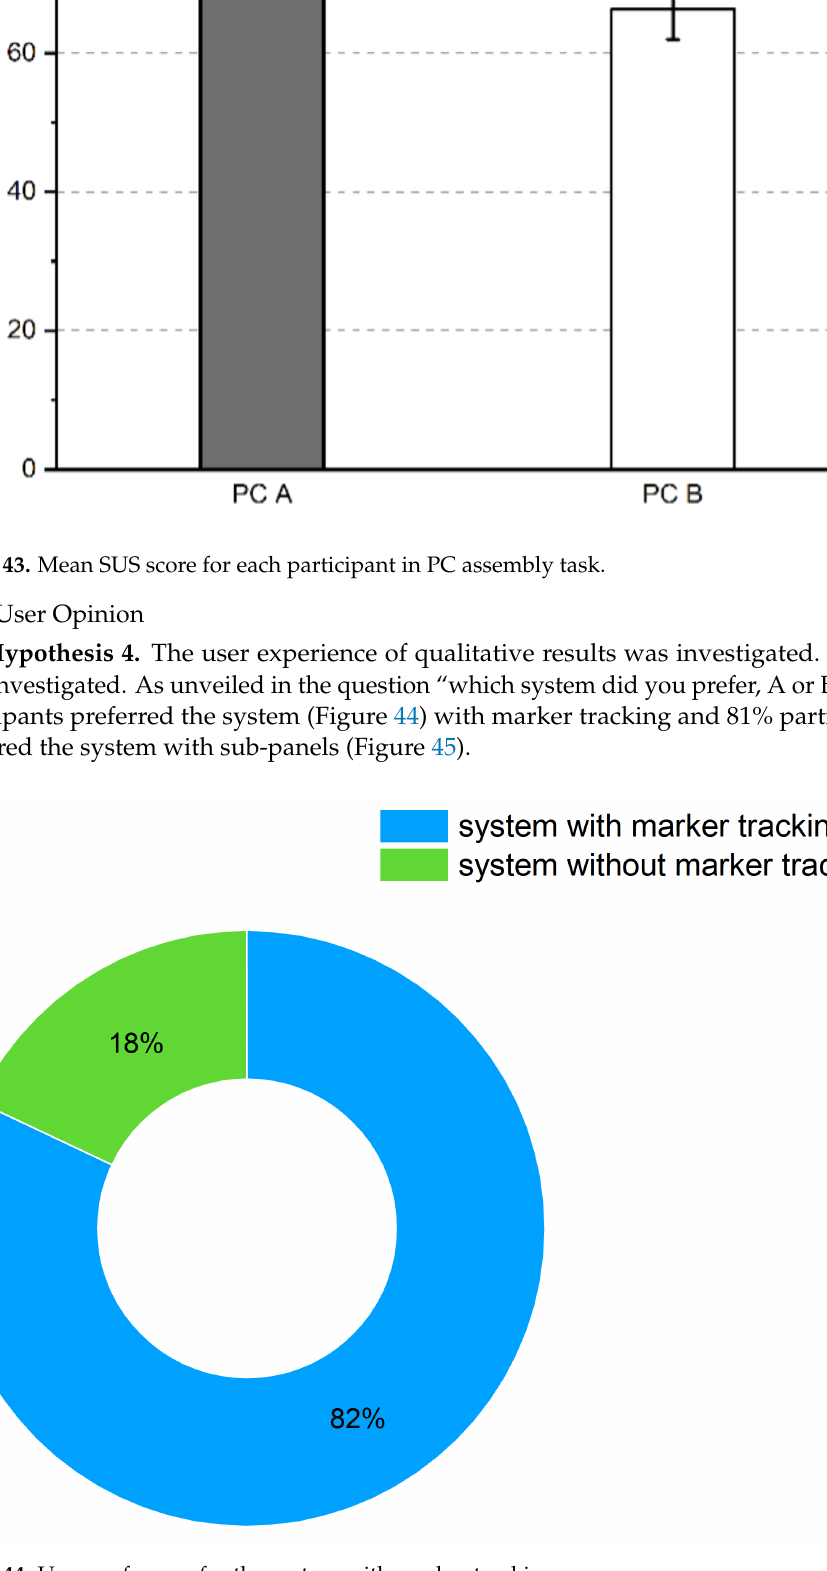
Figure 44. User preference for the system with marker